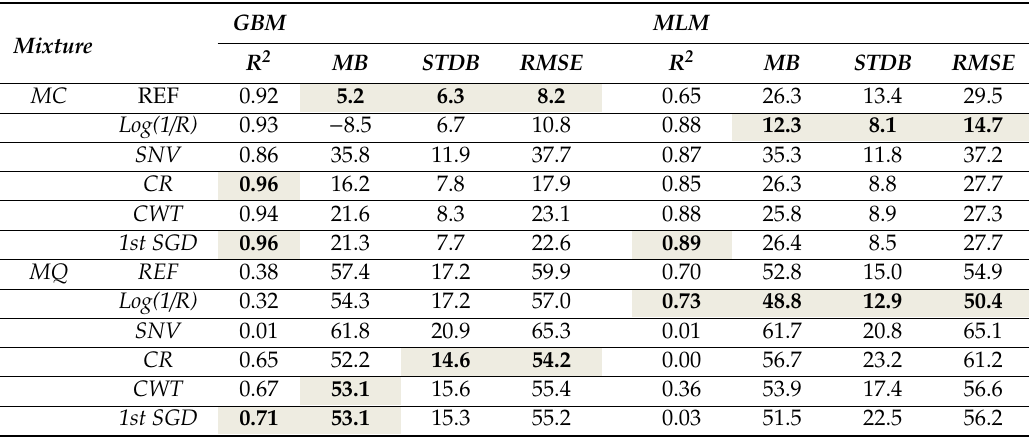
Table 8. Performances of non-linear unmixing methods to estimate montmorillonite abundances for MC and MQ intimate mixtures with di ff erent combinations of spectral preprocessings (best results in grey cells bold font).